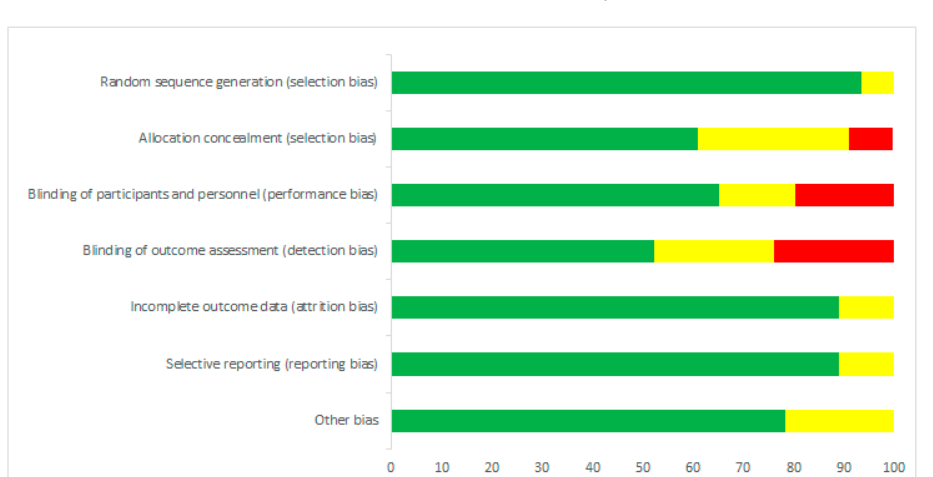
Figure 2. Risk of bias summary.